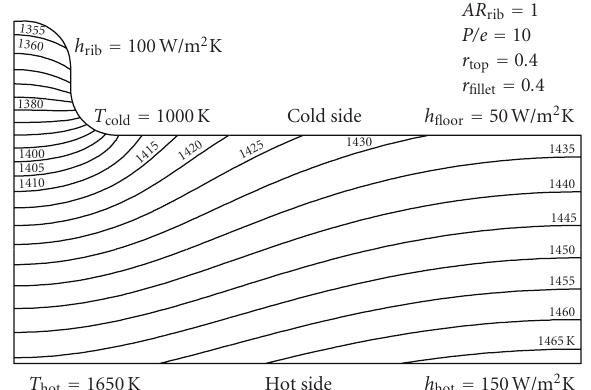
Figure 3: Temperature contours for a typical case.